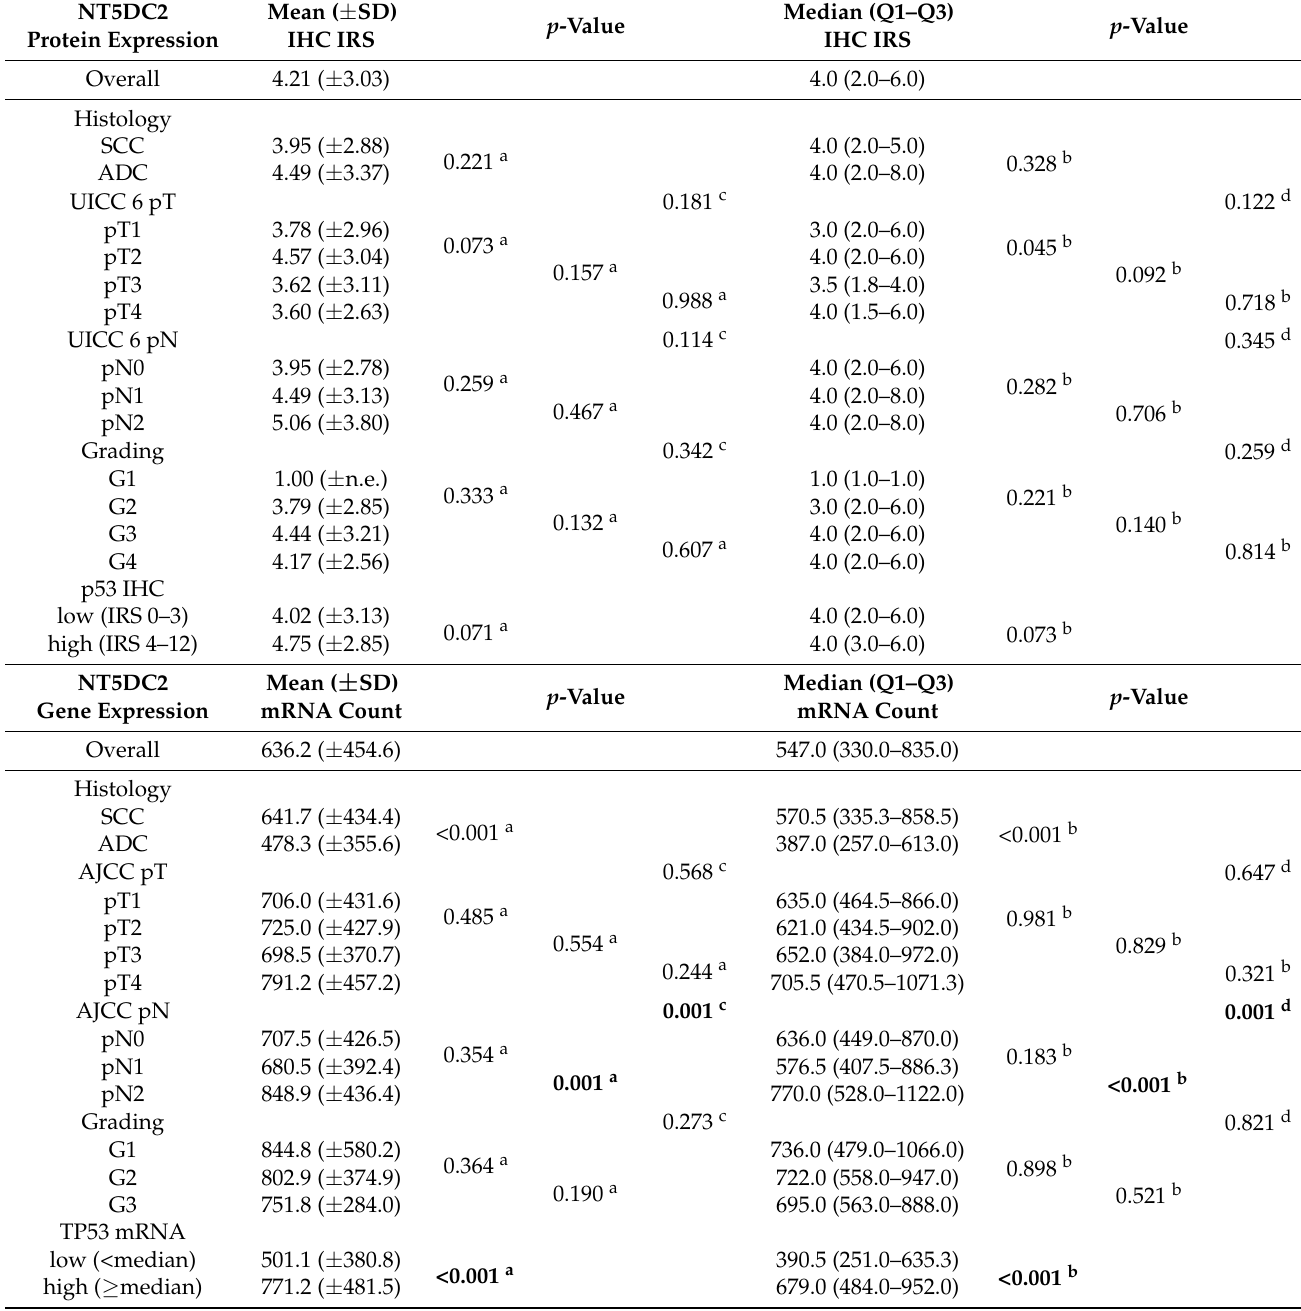
Table 3. Mean and median NT5DC2 IHC IRS and mRNA count in both